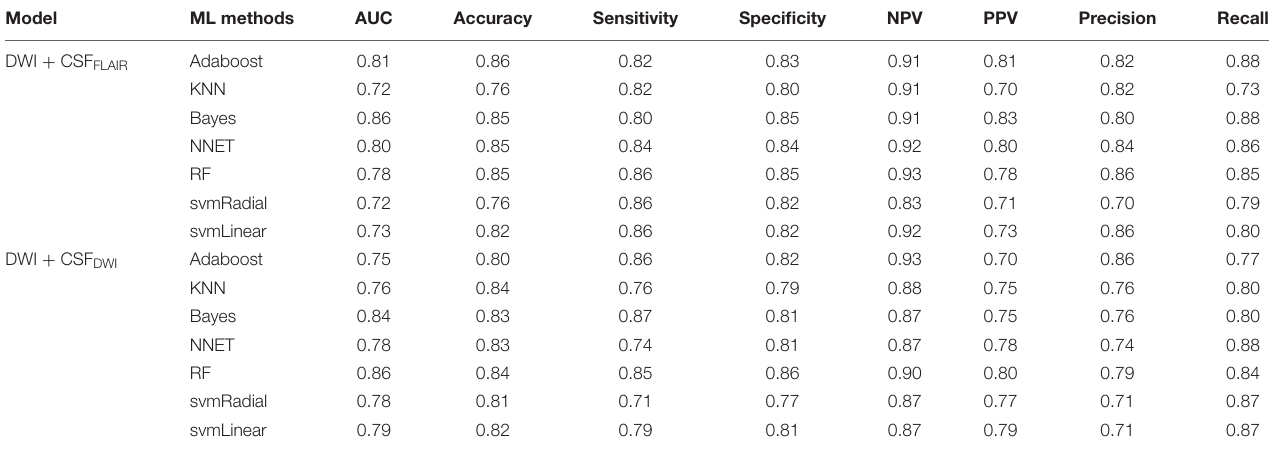
TABLE 2 | The performance metrics of 7 models built with 7machine learning methods. Model ML methods AUC PPV Precision